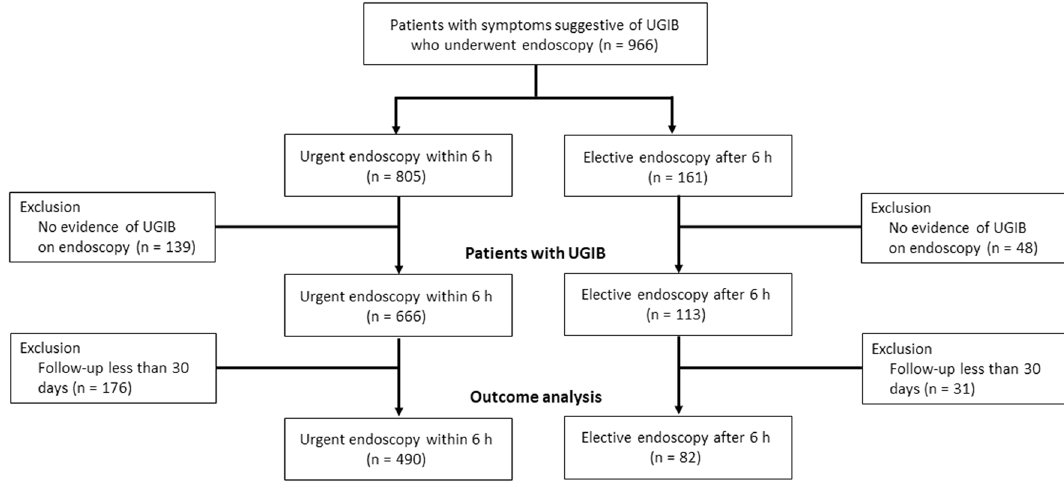
Figure 1. Flowchart of the study. UGIB upper gastrointestinal